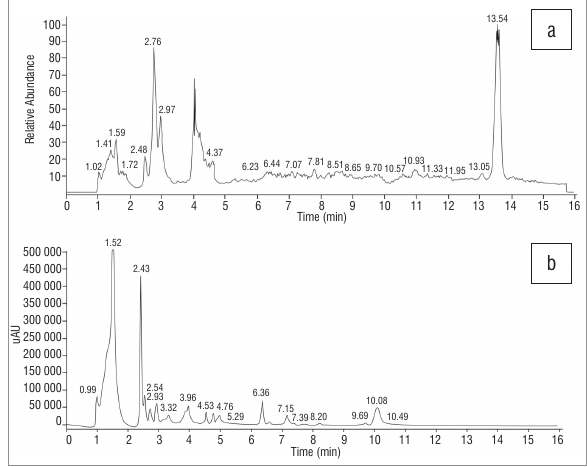
Figure 4 : Chromatograms of Sceletium emarcidum derived from (a) electrospray ionisation mass spectroscopy and (b) high- performance liquid chromatography with UV.